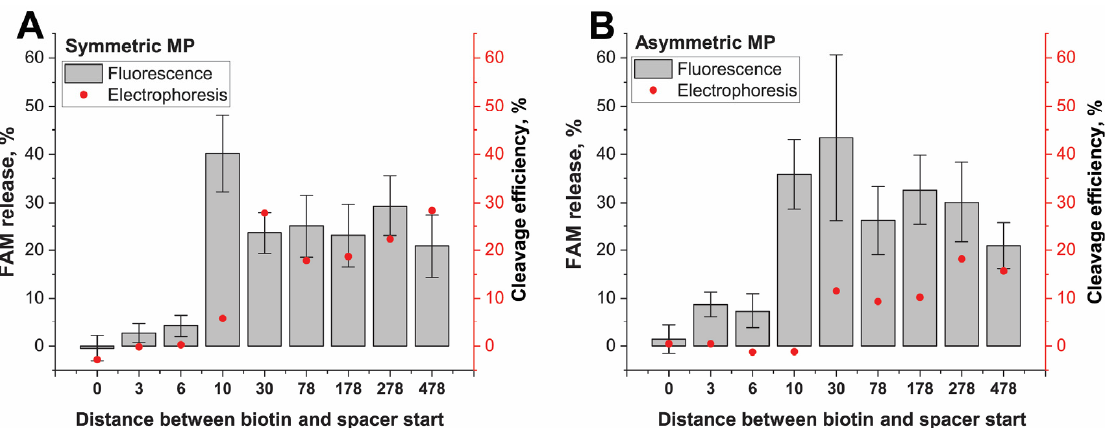
Figure 4. Cis-cleavage of DNA (IGS(I))–streptavidin–MP conjugates differing in the ds-adaptor length between spacer (20 bp) and the MP surface. ( A ) SMPs conjugates, ( B ) AMPs conjugates. Fluorescence values are depicted as gray bars. Efficiency values of cleavage according to gel-electrophoresis are depicted as red dots.